Question: What type of chart is this?
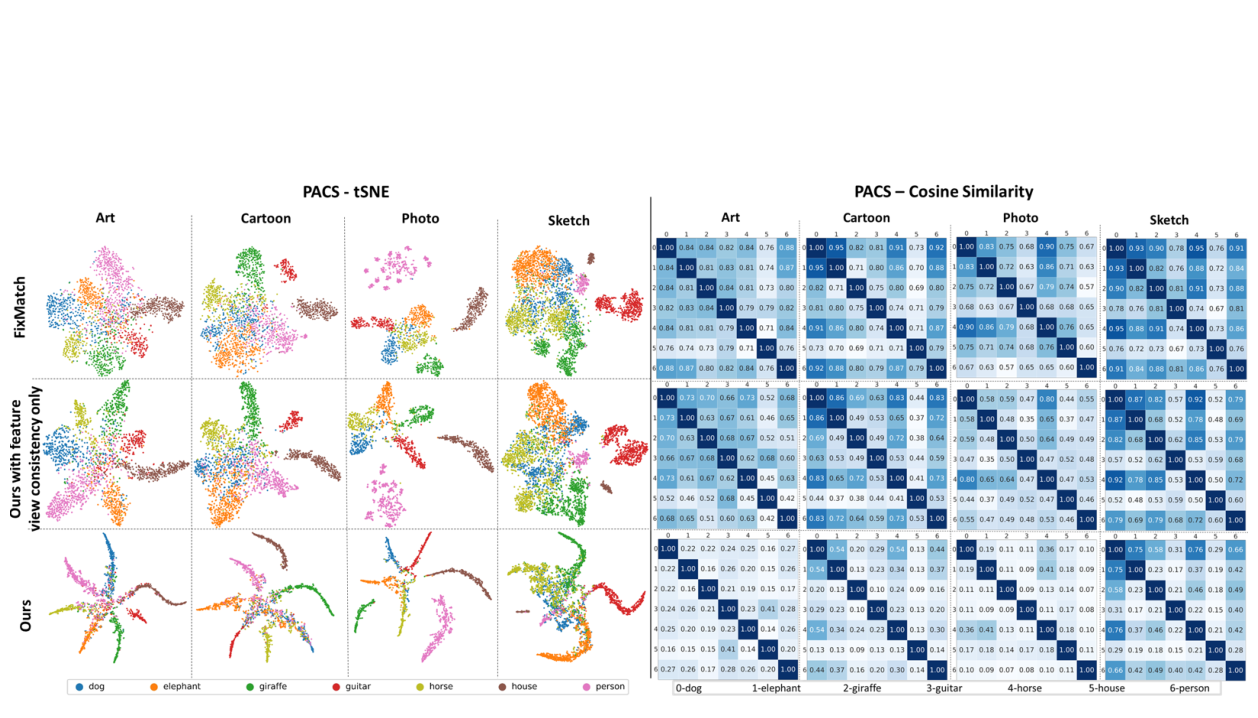
Answer: scatter